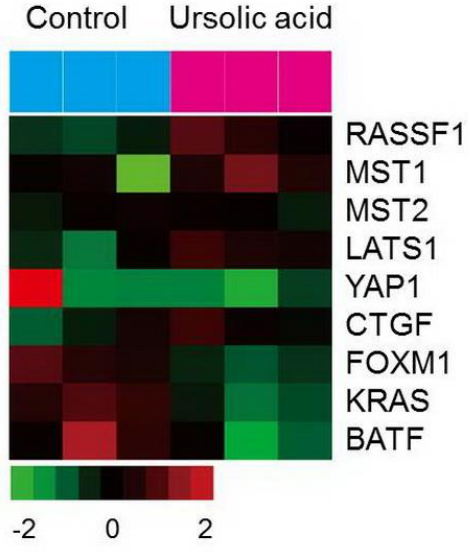
Figure 5. Effect of UA on the invasive rates of gastric cancer cells. SNU484 and SNU638 cells were treated with UA (0, 10, 25, and 50 µ M), the invasion rates were detected by Materigel invasion assay. UA significantly inhibited the cell migration in a dose-dependent manner both at 24 h and 48 h. Data represent the mean ± SE of three independent experiments. ** p < 0.01 and *** p < 0.001 compared to the control.